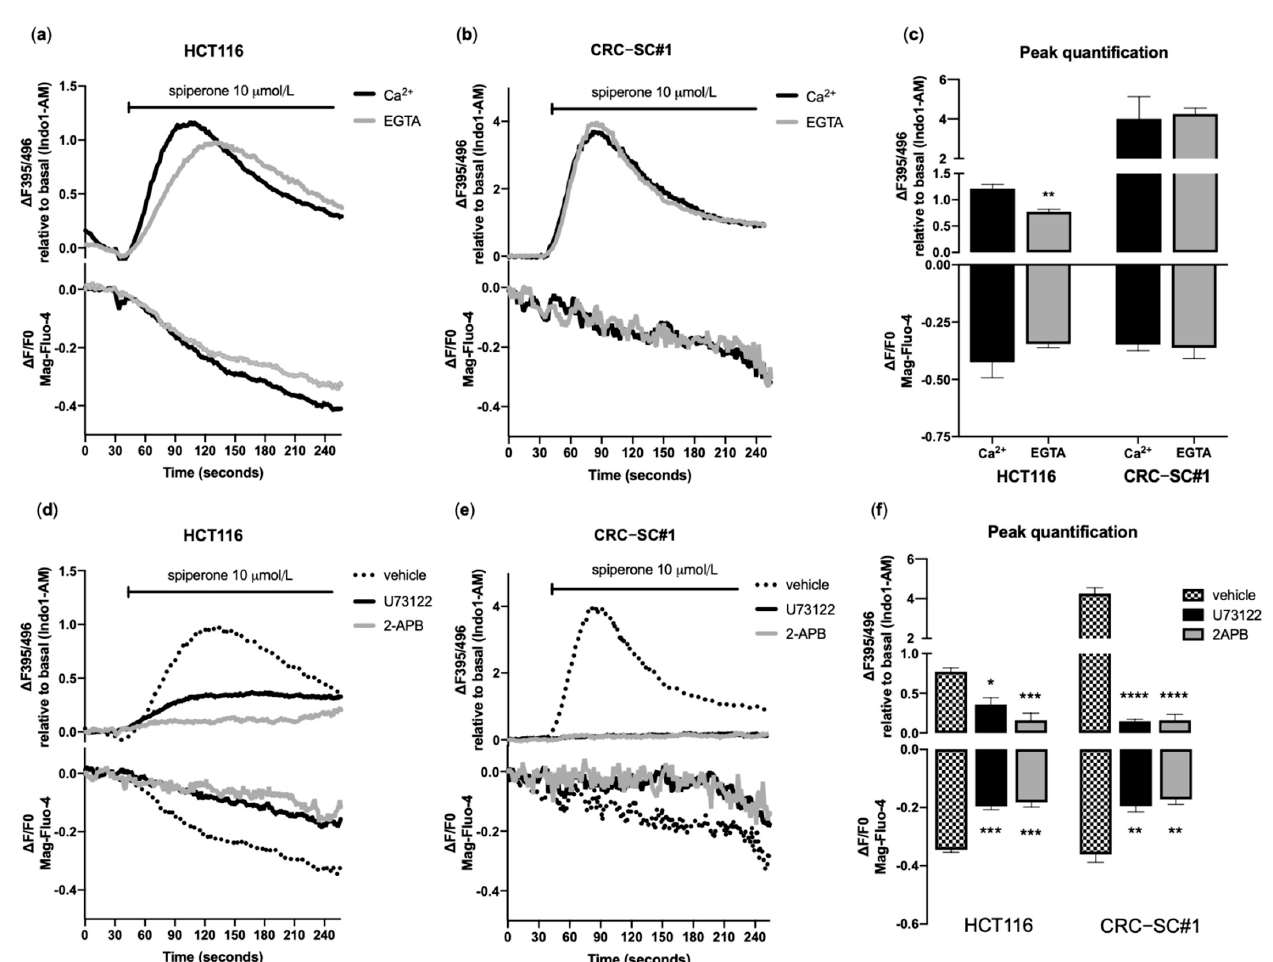
Figure 4. Spiperone increases intracellular Ca 2+ concentration by inducing a PLC-dependent Ca 2+ release from the ER. [Ca 2+ ] cyt (upper panel) and [Ca 2+ ] ER (lower panel) were simultaneously evaluated before and after spiperone exposure. Graphs representing the mean of fluorescence kinetics over time with (black line) or without extracellular Ca 2+ (grey line) in HCT116 ( a ) and CRC-SC#1 ( b ) cells. Histogram displaying quantification of fluorescence peaks relative to basal signal for Indo-1 AM and Mag-Fluo-4 AM in HCT116 and CRC-SC#1 ( c ) cells. Evaluation of the effects of U73122 and 2-APB on spiperone-induced intracellular Ca 2+ modulation, [Ca 2+ ] cyt (upper panel), and [Ca 2+ ] ER (lower panel) were simultaneously evaluated in the absence of extracellular Ca 2+ before and after spiperone exposure. Graph representing the mean of fluorescence kinetics over time in cells pretreated with vehicle (dotted black line), U73122 10 μ mol/L (solid black line), and 2APB 50 μ mol/L (solid grey line) in HCT116 cells ( d ) and CRC-SC#1 cells ( e ). Histogram displaying quantification of CRC-SC line #1 ( f ). Data represent the mean ± SD of at least three independent experiments. *: